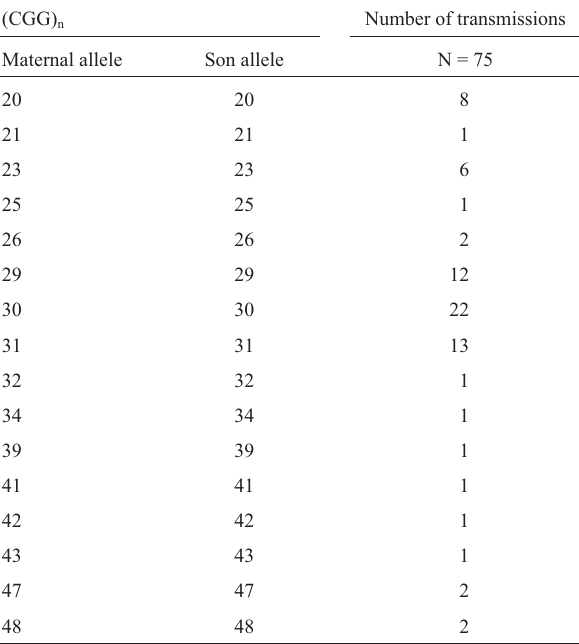
Table 1 - Distribution of 75 stable maternal transmissions of FMR1 normal and intermediate